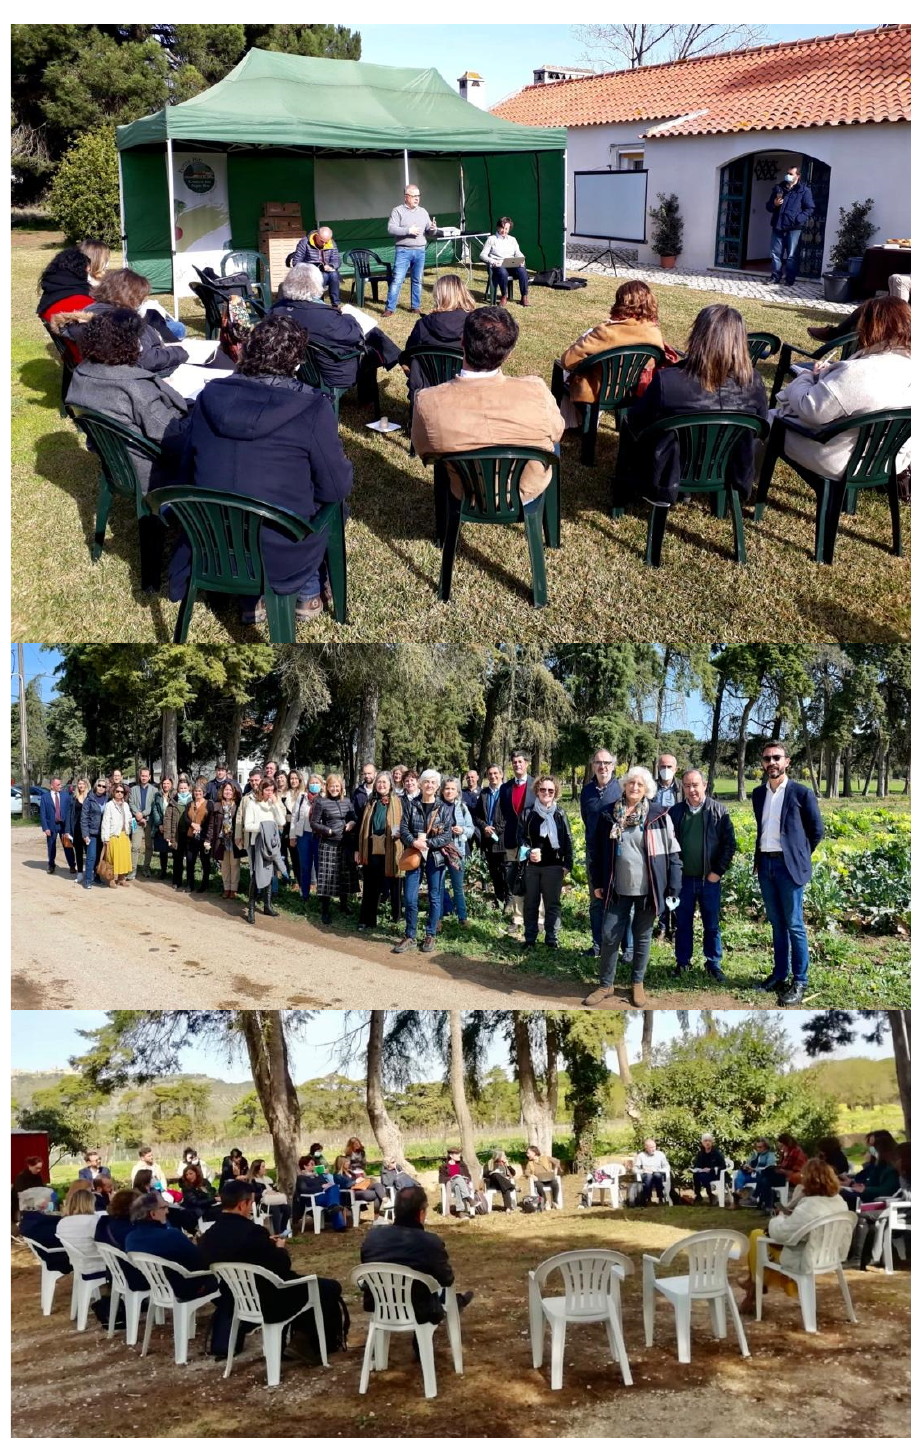
Figure 2. Examples of MNAP meetings.